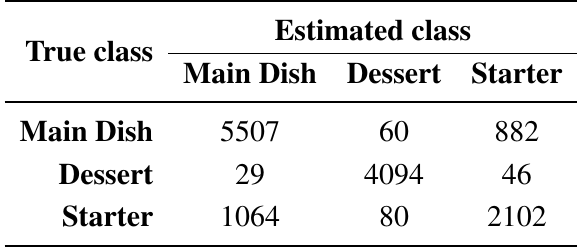
Table 12. Confusion matrix for system T2 on training corpus on task 2.